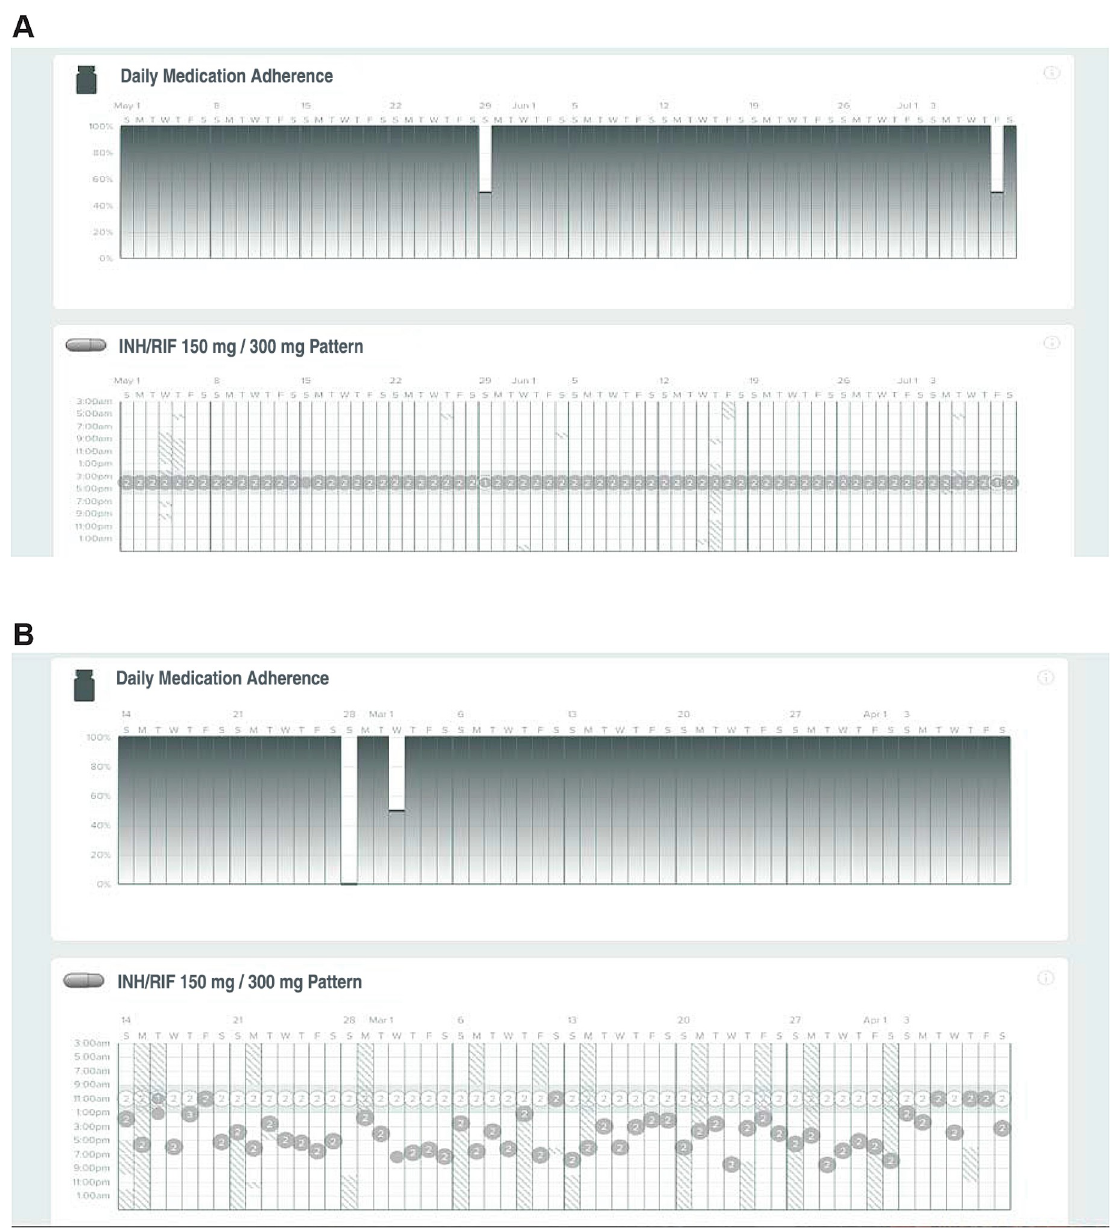
Fig 3. Longitudinal patterns of taking and timing adherence data of IS-Rifamate using WOT in two participants. The first participant has highly regular taking and timing adherence, in this case achieved by setting an alarm reminder. The second participant displays variable timing adherence, but taking adherence is maintained with WOT adherence support. INH, isoniazid; IS, ingestion sensor; IS-Rifamate, IS-enabled combination isoniazid 150 mg/rifampin 300 mg; RIF, rifampin; WOT, wirelessly observed therapy.